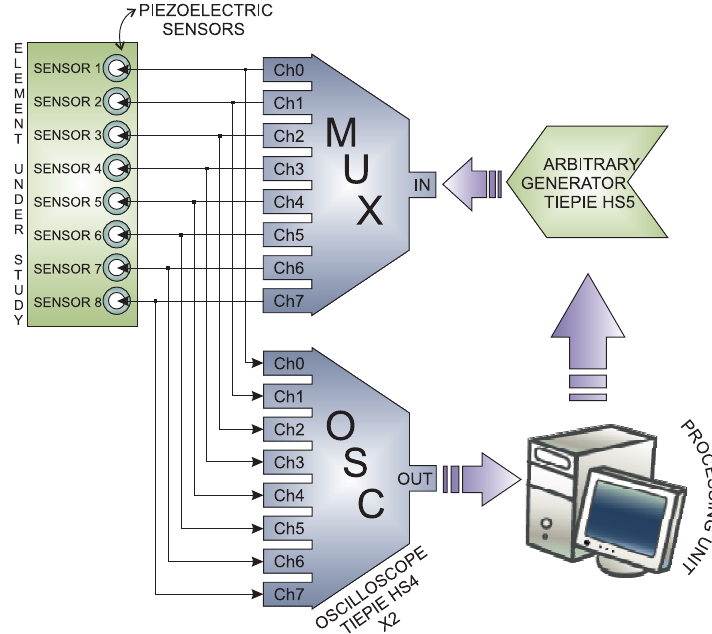
Figure 6. Representation of the structural health monitoring (SHM) system.